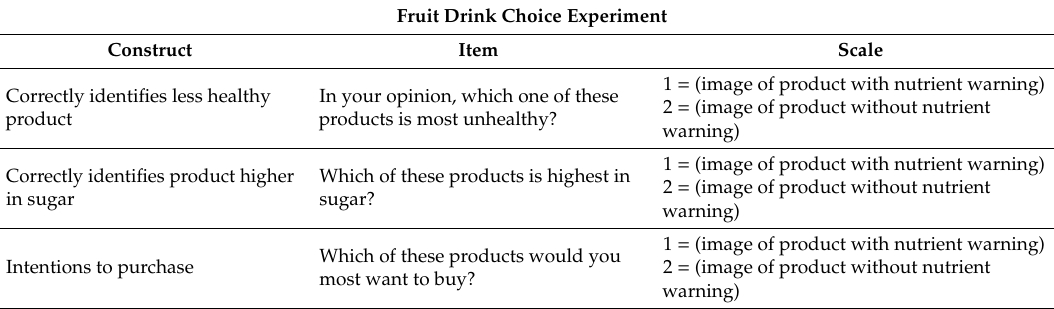
Figure A1. Products with circle labels used in the experiment. Table A1. Constructs, item wording, and scales for label and product reactions.